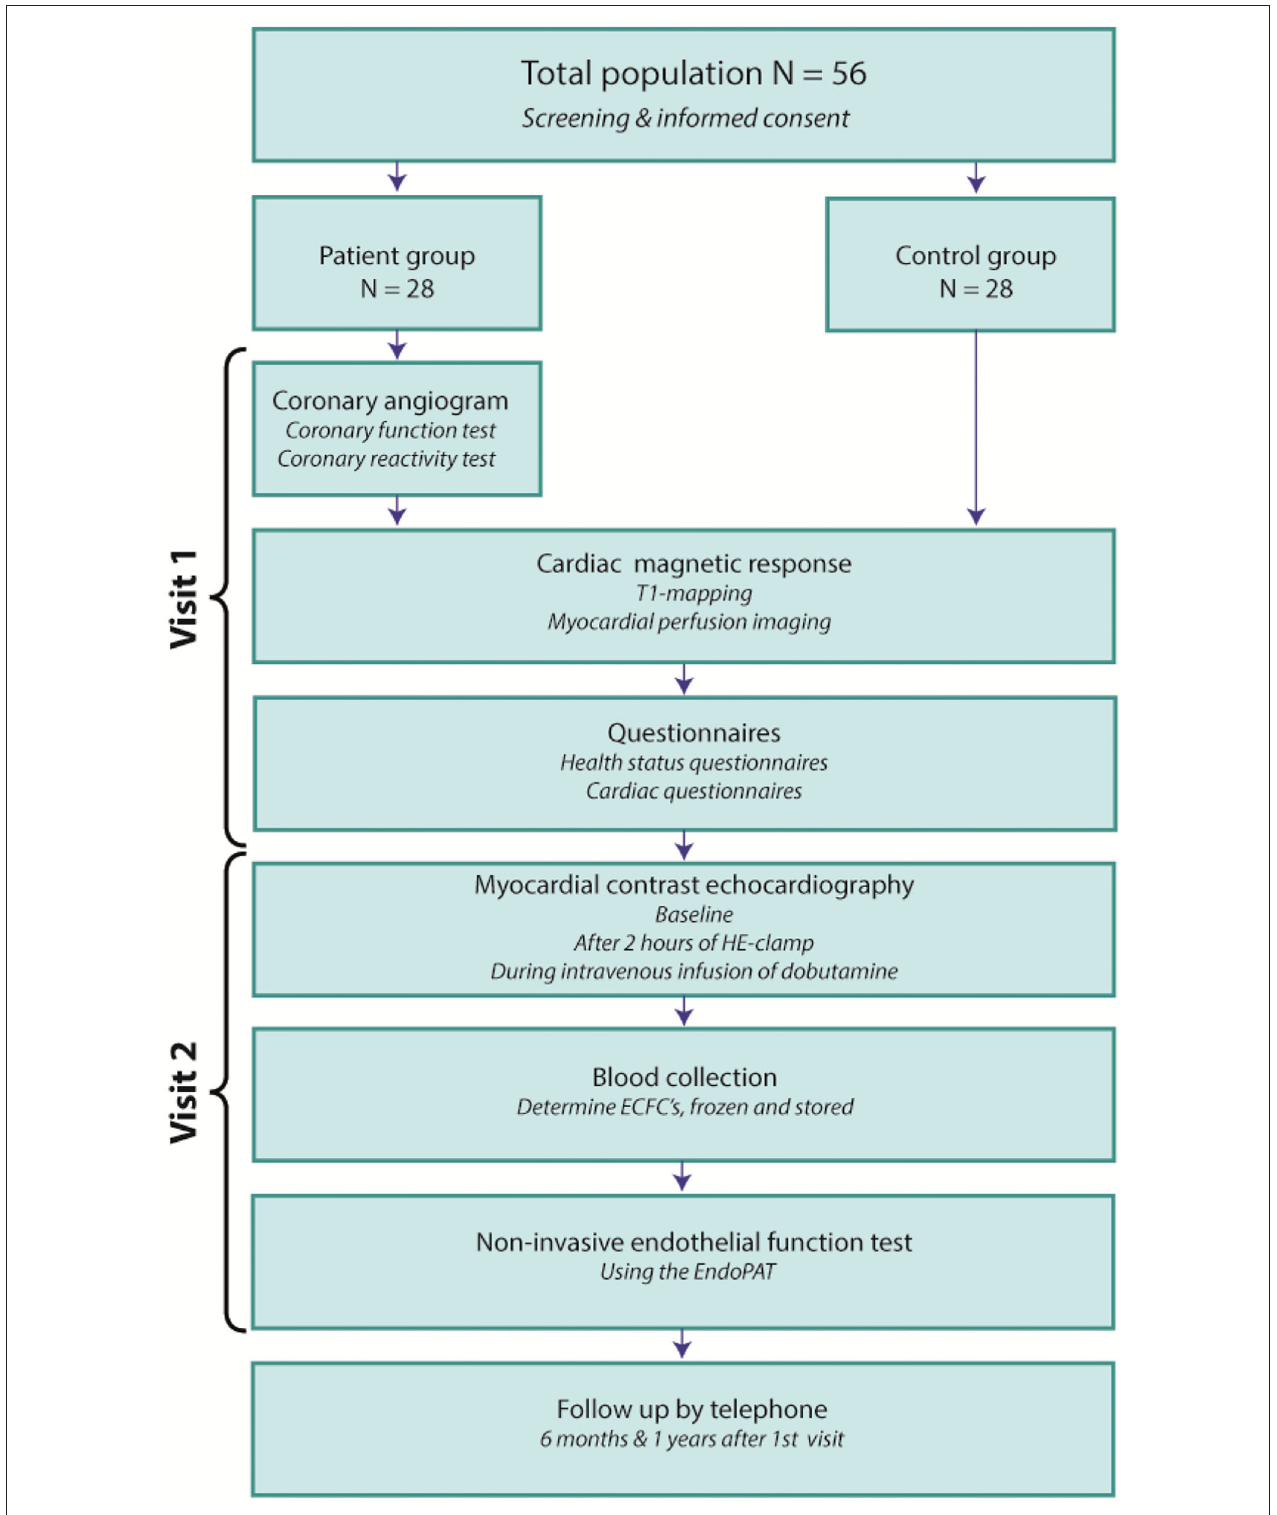
FIGURE 1 | The MICORDIS-study protocol. HE-clamp, hyperinsulinemic-euglycemic clamp; ECFC’s, circulating endothelial colony forming cells; EndoPAT, Peripheral Artery Tonometer.